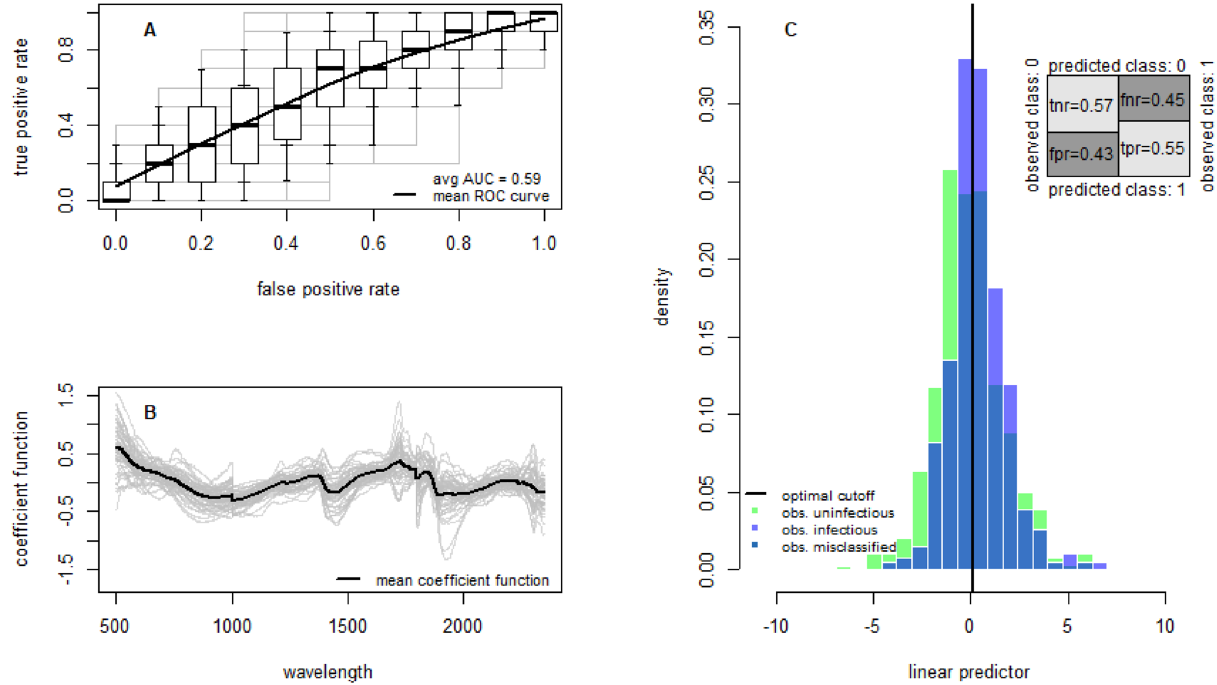
Figure 2. The ability of NIRS to predict field caught mosquitoes with high number of sporozoites. All models were trained using mosquitoes infected in the wild and were either sporozoite positive mosquitoes with > 20 sporozoite per Anopheles (20 gene copy number as defined by qPCR) or sporozoite negative mosquitoes (Table 1). ( A ) The receiver operating characteristic (ROC) curve for the best-fit model demonstrating how the false positive and true positive rates vary for different for different classification probability thresholds. Overall performance is given by the average area under the ROC curve (AUC). A perfect model with 100% sensitivity and specificity would be in the top left corner. Solid line shows the average ROC curve with boxplots showing the variability for 50 randomizations of the training, validation and testing datasets (with box edges, inner and outer whiskers showing 25th/75th, 15th/85th and 5th/95th percentiles, respectively; and the black line inside the box showing the median/50th-percentile). ( B ) Coefficient functions for the best fit model for each of the 50 dataset randomizations (grey lines) and the corresponding average (black line). ( C ) The histogram of the estimated linear predictor for the test mosquitoes, the green and light blue colored bars indicate the true class, showing the model’s ability to separate the two groups of mosquitoes. Vertical black line indicates the best threshold for differentiating infectious or uninfectious mosquitoes. The darker blue shaded area where the two distributions overlap corresponds to mosquitoes which have been misclassified—false negatives to the left and false positives to the right of the optimal classification threshold. Inset shows the confusion matrix reporting the different error rates: tnr, true negative rate (specificity); fnr, false negative rate; fpr, false positive rate; and tpr, true positive rate